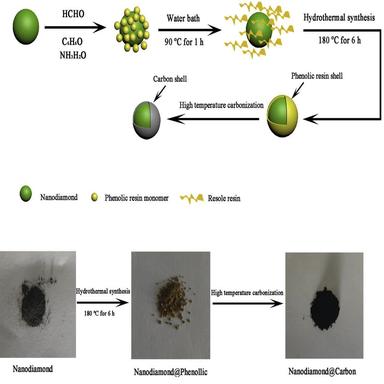
Schematic illustration of D@C nanocomposite paticles.